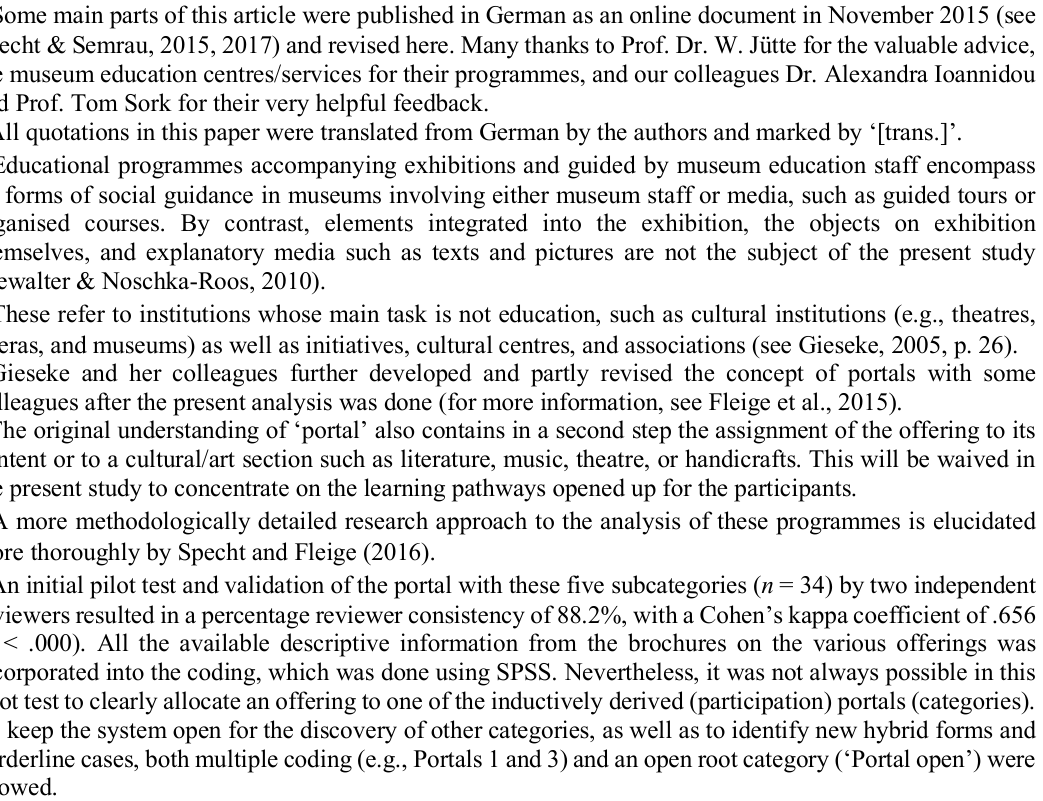
Table E1 . Frequency and percentage of the formats of event of the sample ( N = 709)